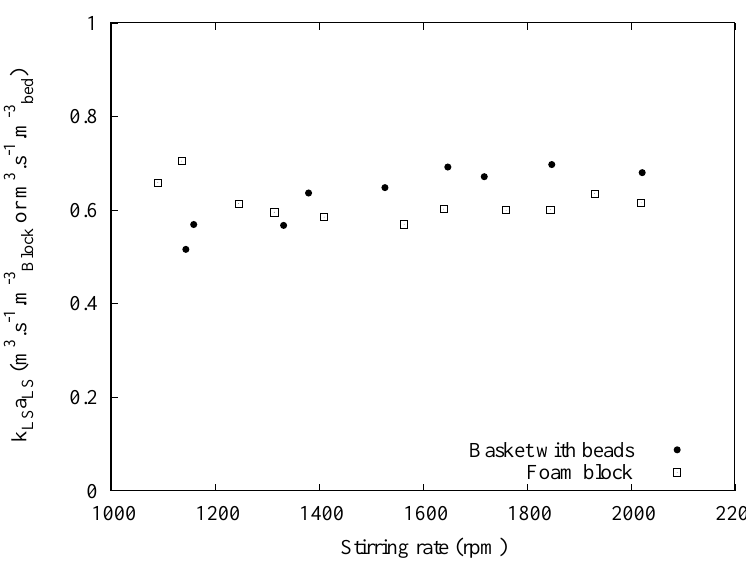
Figure 5. LS (Liquid–solid) mass transfer—comparison between the basket with 2 mm beads and the 40 PPI foam